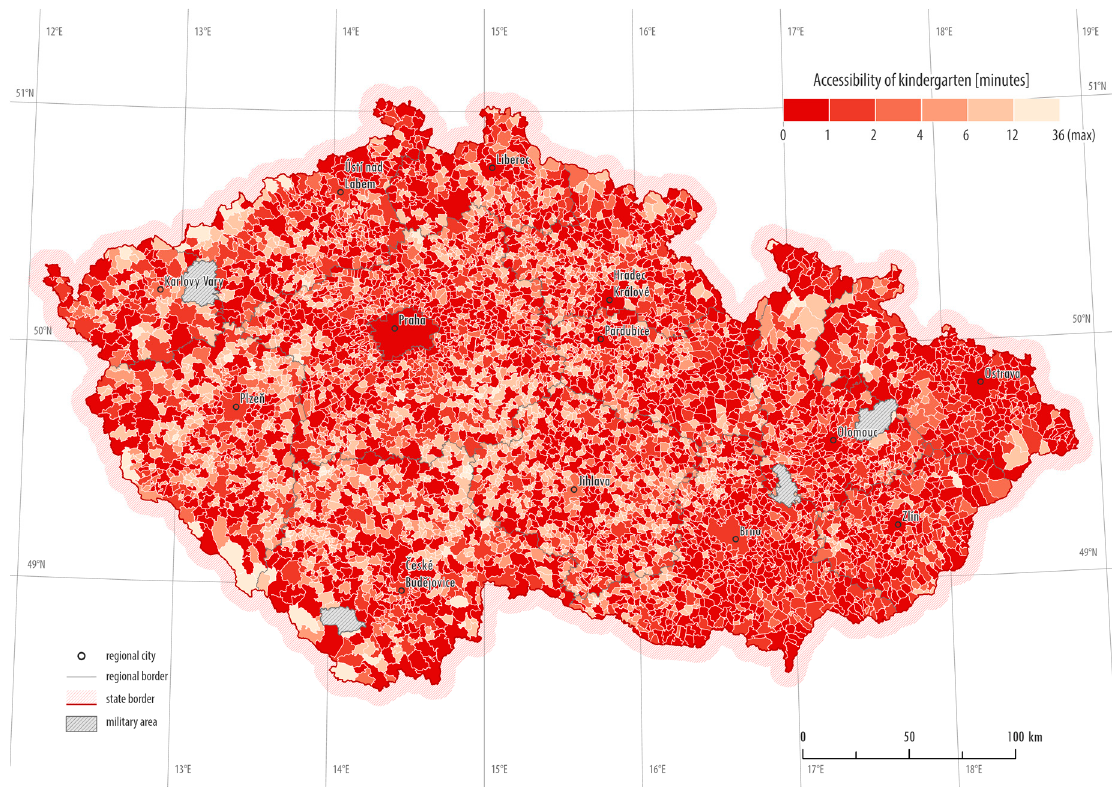
Figure A2. Accessibility of